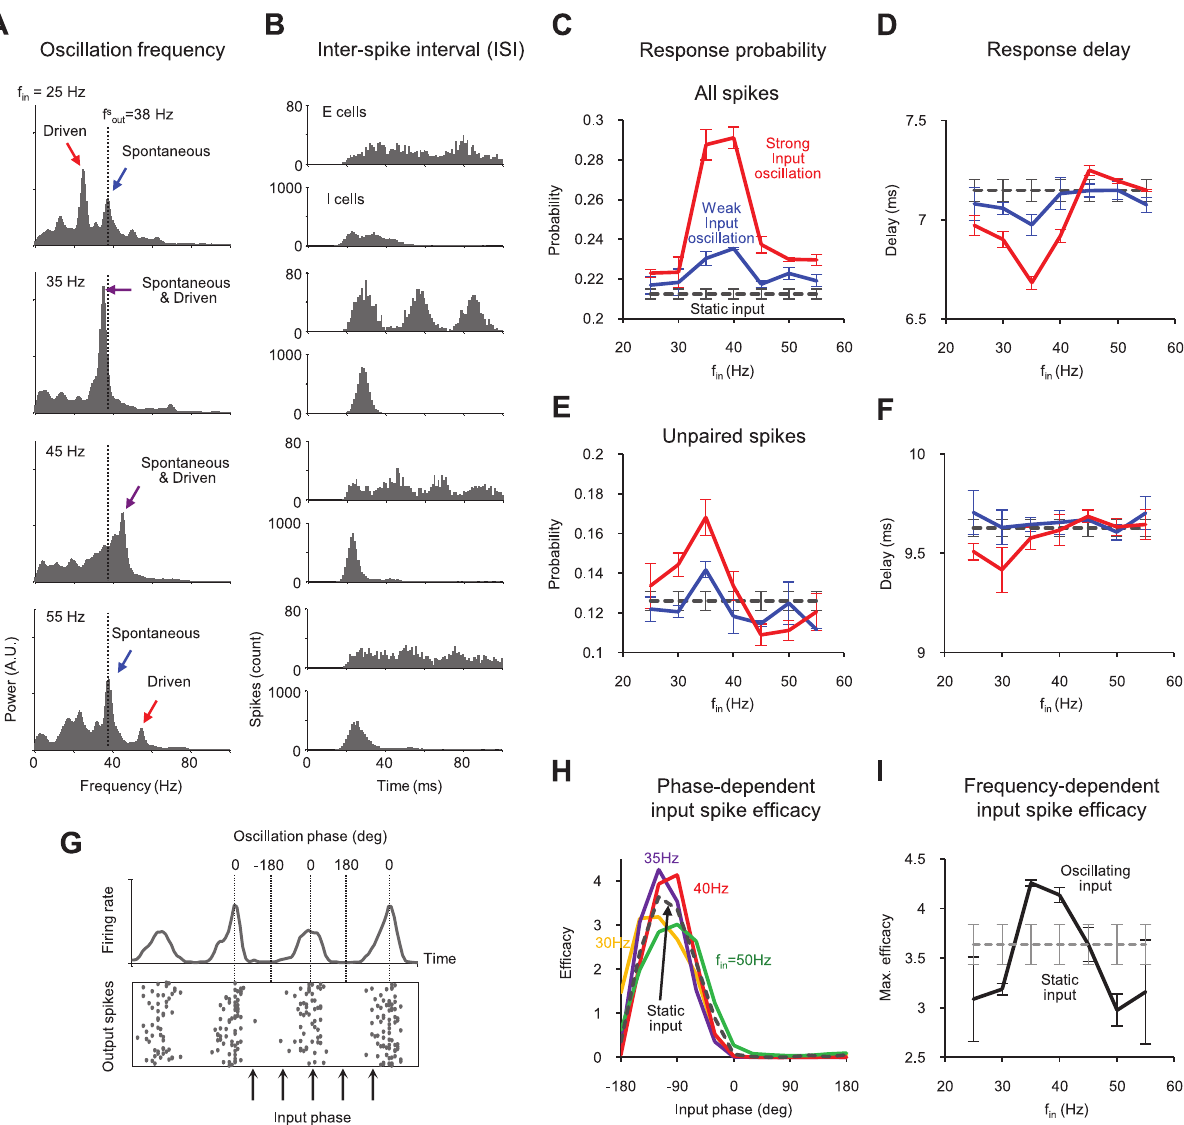
Figure 2. Population response modulation by the resonance between spontaneous and driven gamma oscillations. (A) Cortical output oscillation power spectrum and (B) ISI distributions for sinusoidally oscillating inputs. Note that the resonance between spontaneous and driven oscillations occurs only when input frequency (f in ) is close to spontaneous gamma frequency (f s out ). (C) Response probability and (D) Response delay to all input spikes of various oscillation frequencies. (E) Response probability and (F) Response delay to temporally ‘‘unpaired’’ input spikes. (G) Relative input timing (phase) in a gamma oscillation cycle. (H) Variation of input spike efficacy by input phase. The efficacy of unpaired input spikes was defined as the relative probability to generate cortical spike, and was measured as a function of input phase. The efficacy was normalized so that the average of each set was set to unity. (I) Maximum input spike efficacy in (H). This shows the network’s ability to ‘‘gate’’ or synchronize its output signals.